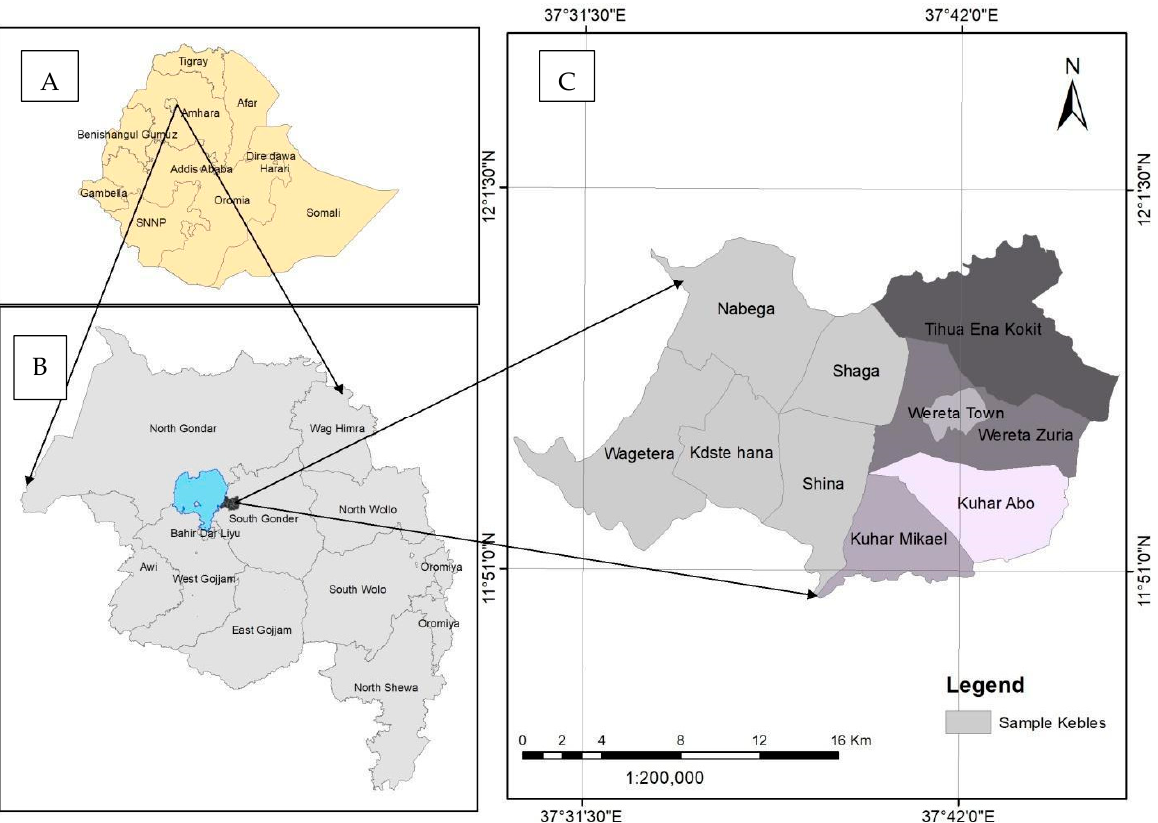
Figure 1. Map of Fogera Woreda, including its biosphere reserve (BR). ( A ) A map of Ethiopia with regional boundaries, ( B ) the Amhara region containing the BRs and Lake Tana, and ( C ) the districts of Fogera and sample kebeles.